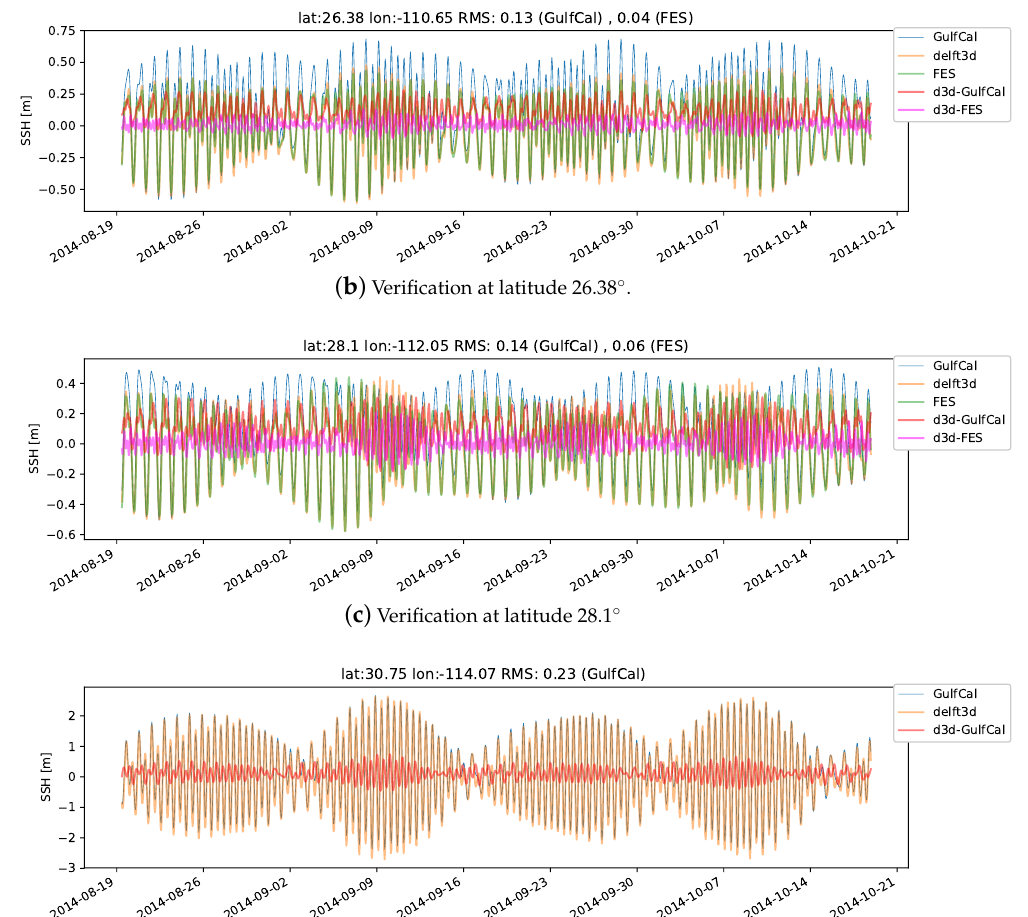
Figure 5. Model verification against sea surface height (SSH) from GulfCal and FES14. Difference plots are indicated in the legend as “diff”. All dates in